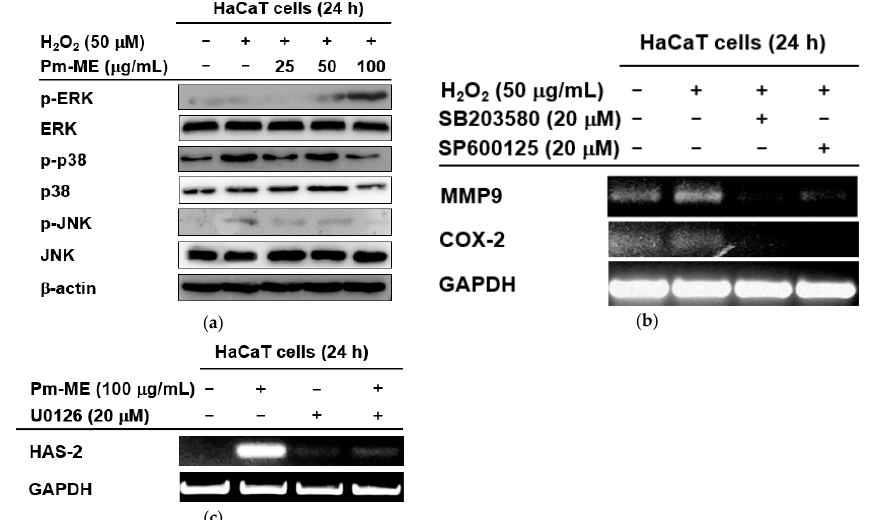
Figure 5. The effect of Pm-ME on the activation of MAPK in HaCaT cells. ( a ) HaCaT cells pre-treated for 30 min with Pm-ME (0–100 µg/mL) were treated with H 2 O 2 (50 µM) for 24 h. Total and phospho-form levels of ERK, p38, and JNK were measured by Western blot. ( b ) HaCaT cells pre-treated with SB203580 (20 µM) or SP600125 (20 µM) for 30 min were treated with H 2 O 2 (50 µM) for 24 h. The expression levels of MMP-9 and COX-2 were measured using semi-quantitative RT-PCR. ( c ) HaCaT cells pre-treated with U0126 (20 µ M) for 30 min were treated with Pm-ME (100 µ g/mL) for 24 h. The mRNA expression levels of HAS-2 and COL1A1 were determined by semi-quantitative RT-PCR.